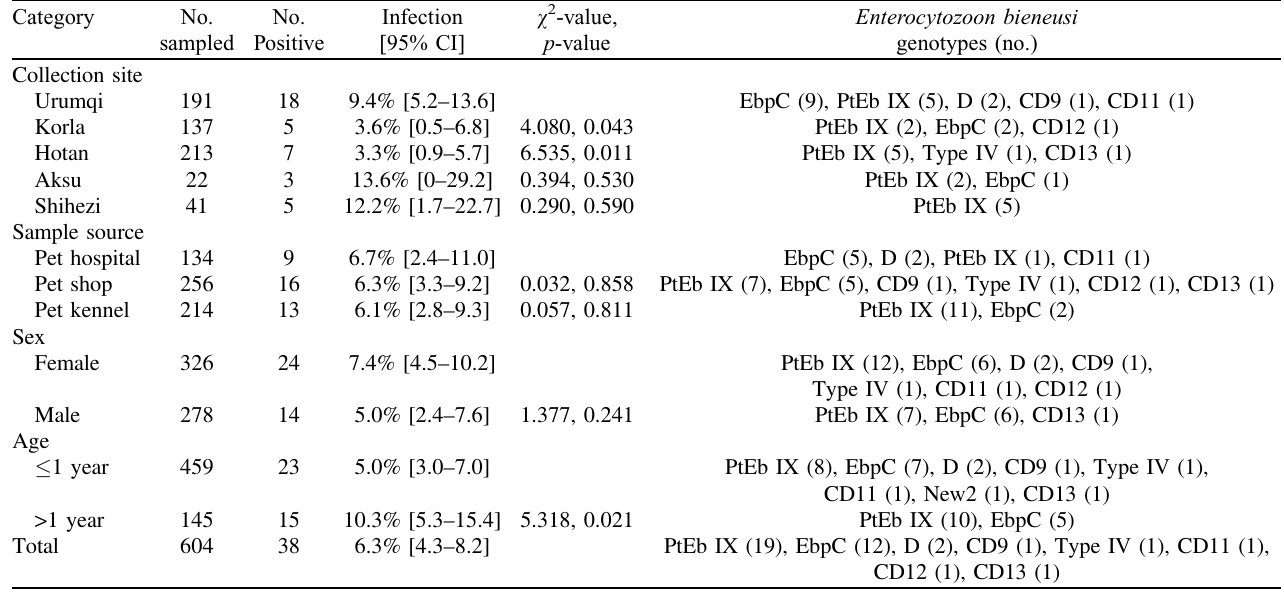
Table 1. Distributions of E. bieneusi in pet dogs from Xinjiang, China.